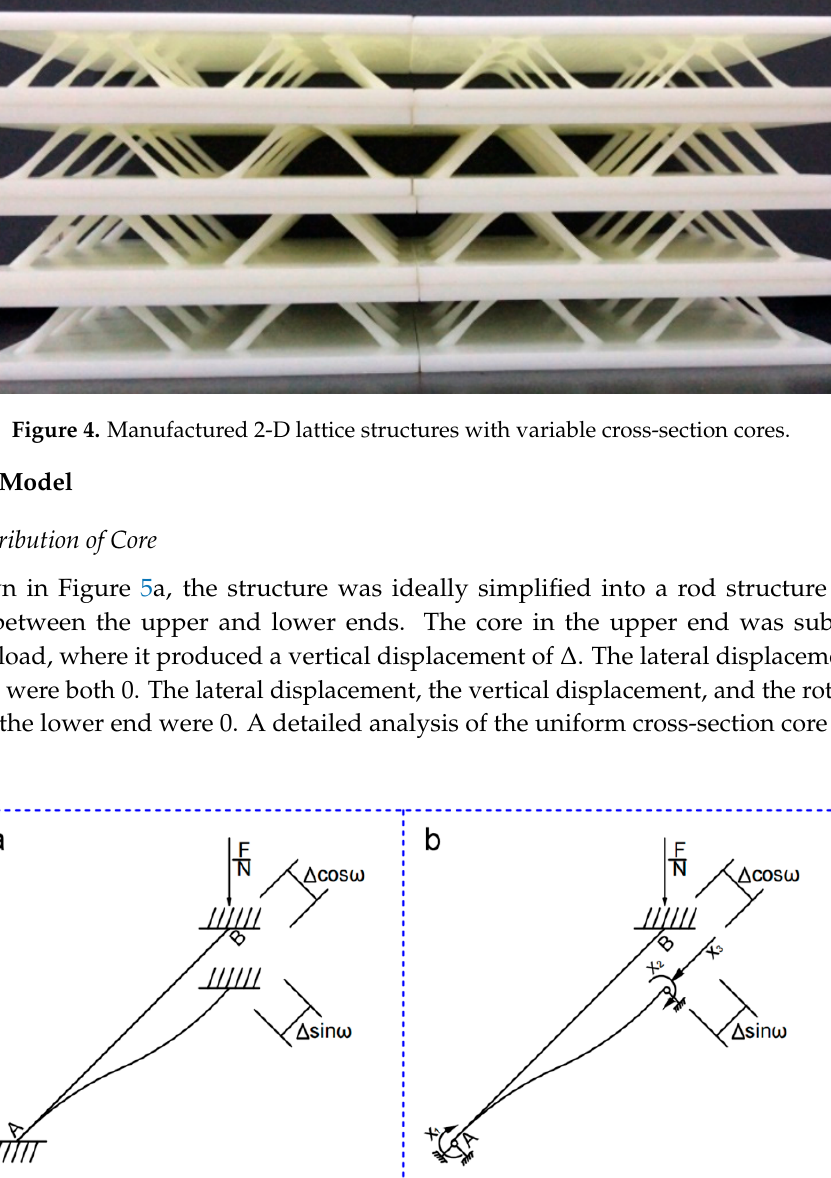
Figure 3. 2-D lattice structure with variable cross-section core shaping technology.